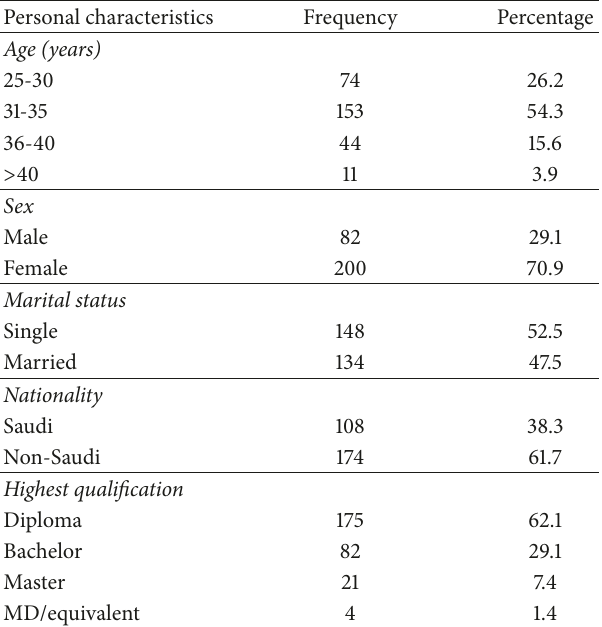
Table 1: Personal characteristics of the emergency department physicians and nurses (n=282).